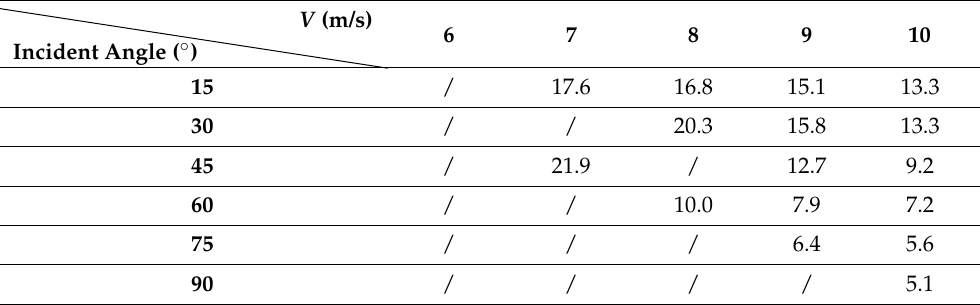
Table 3. Splash timetable for droplets with different incident angles (flat wire)/ μ s.